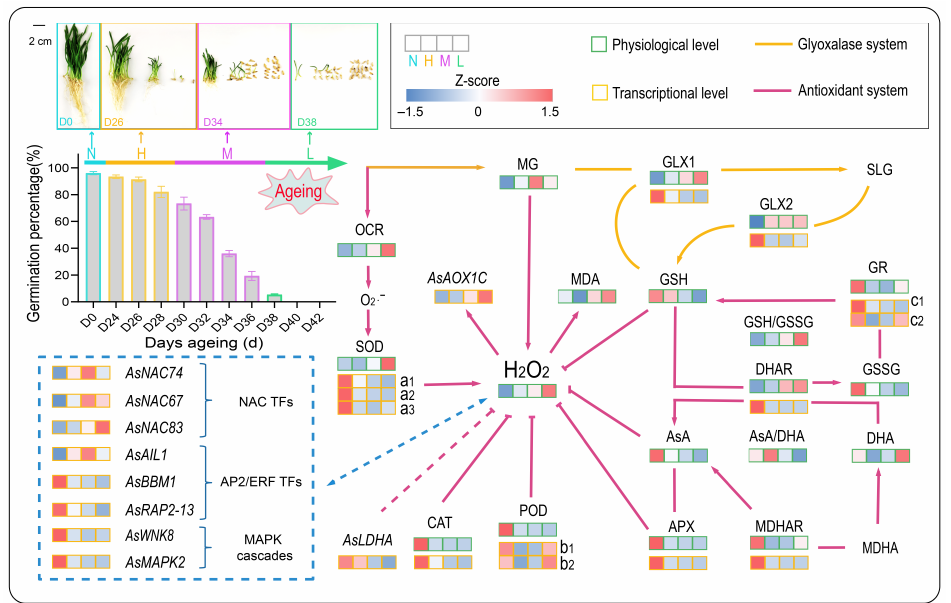
Figure 12. Putative physiological and transcriptional response model for varying degrees of aging in oat seeds. N, H, and L represent three vigor level of groups, non-aged group (Group N), high vigor group (Group H), and low vigor group (Group L), respectively. Orange and green rectangles represent changes in transcriptional expression level and physiological level, respectively. All the data of 48 indicators was normalized (Z-score) based on the mean and standard deviation. The lowercase characters represent genes of AsCu/Zn-SOD (a1), AsFe-SOD (a2), AsMn-SOD (a3), AsPOD1 (b1), AsPOD12 (b2), AsGR1 (c1), and AsGR2 (c2).